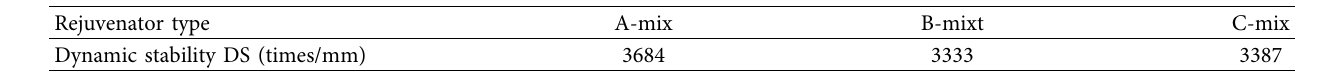
Table 7: Results of 60 ° C rutting test on rejuvenated asphalt mixes.